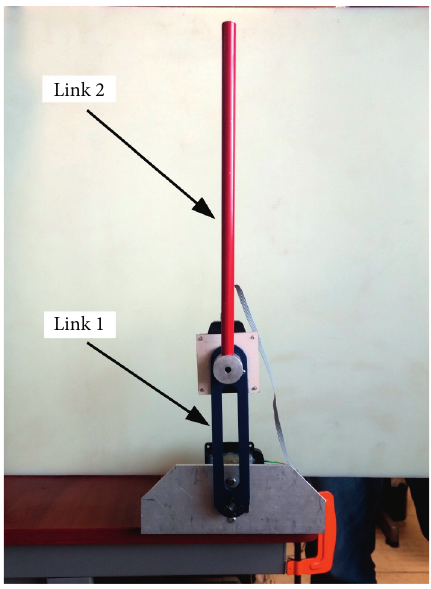
Figure 14: Pendubot